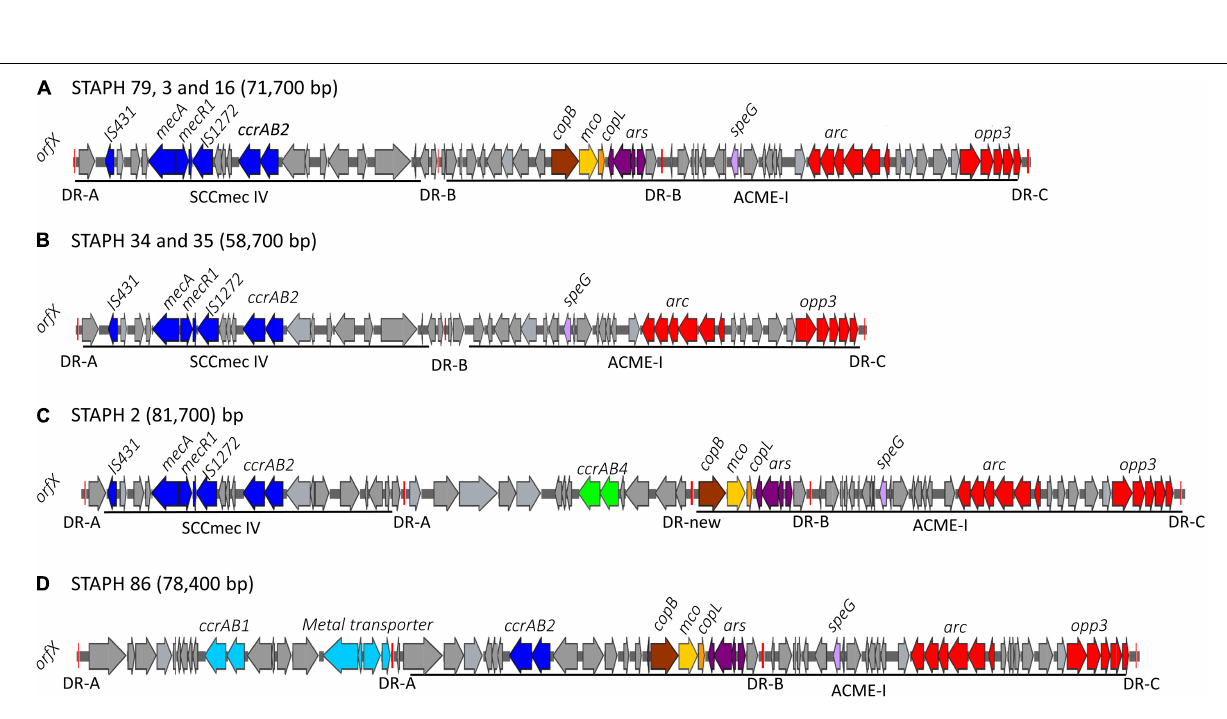
FIGURE 3 | Schematic map of the ACME-I in S. epidermidis . comparative organization of ACME-I composite island in the seven ST48, ST54, ST35 S. epidermidis isolates. The size of each ACME composite island is indicated after the strain names. Four distinct ACME-I composite island were defined according to the additional modules in these elements (A–D) . Each gene or group of genes of interest is shaded in color; arc and opp3 operons (red), speG (light purple), copB (brown), mco (light yellow), copL (ornage), ars operon (dark purple), mecA, mecR1, IS431, IS1272, and ccrAB2 (dark blue). The direct repeat (DR) sequences DRA, DR-B, DR-C, and the new DR are